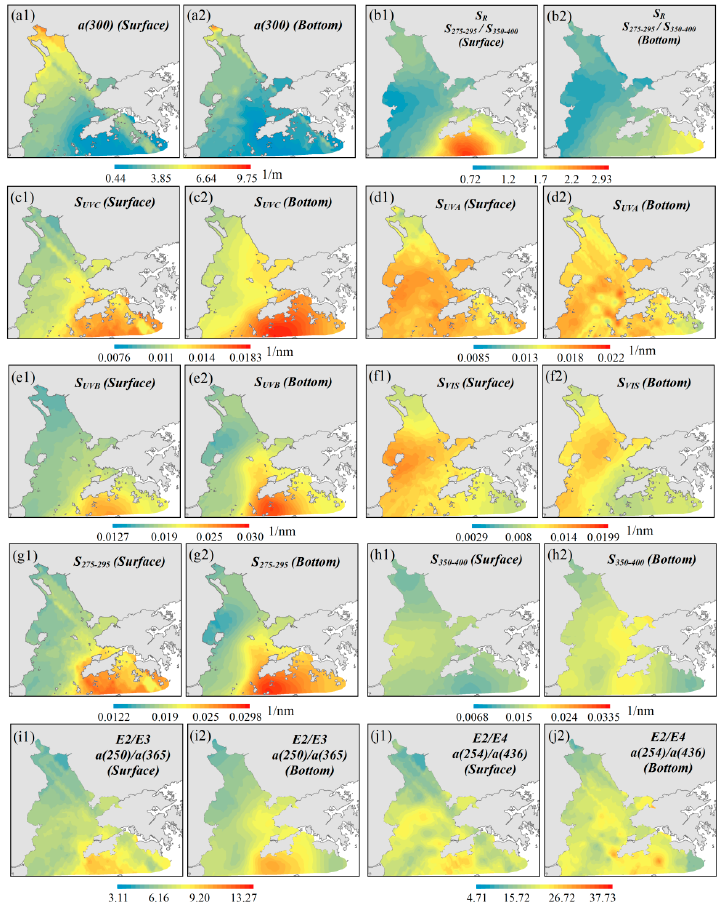
Figure 5. Surface and bottom variation of: ( a ) CDOM absorption a (300); ( b ) the spectral slope ratio S R ( S 275–295 / S 350–400 ); ( c – h ) spectral slopes S UVC (250–280 nm), S UVB (280–315 nm), S UVA (315–400 nm), S